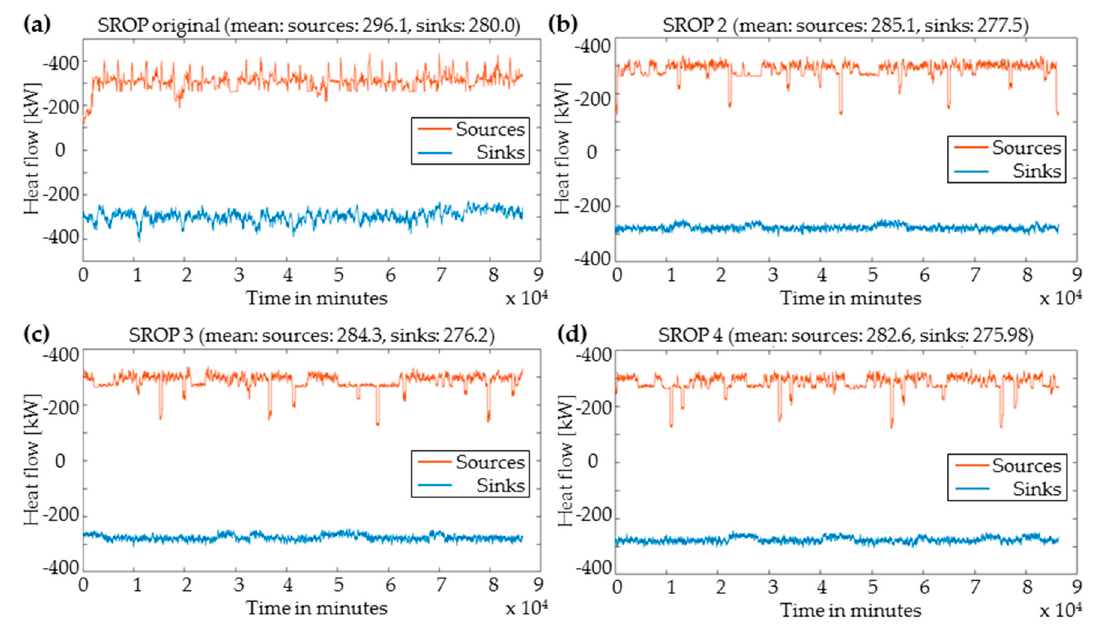
Figure 13. ( a ) Original and ( b – d ) exemplary total available source and sink streams of one stream-wise repeat operation periods (SROPs).